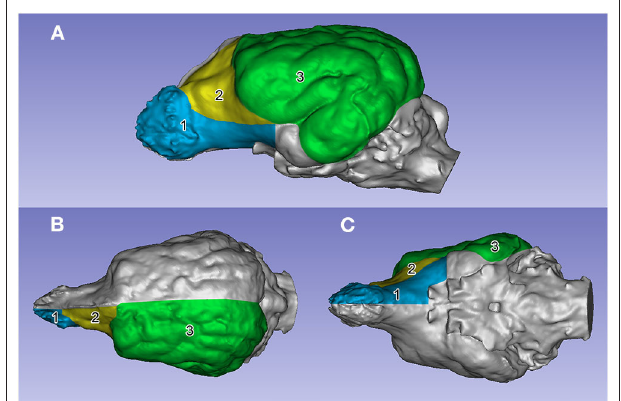
FIGURE 7 | The segmented surface regions on the left side on an English setter’s endocast. (A) Left lateral view. (B) Dorsal view. (C) Ventral view. (1) Prepiriform rhinencephalic area (in blue). (2) Prefrontal area (in yellow). (3) Non-prefrontal cerebral convexity area (in green).